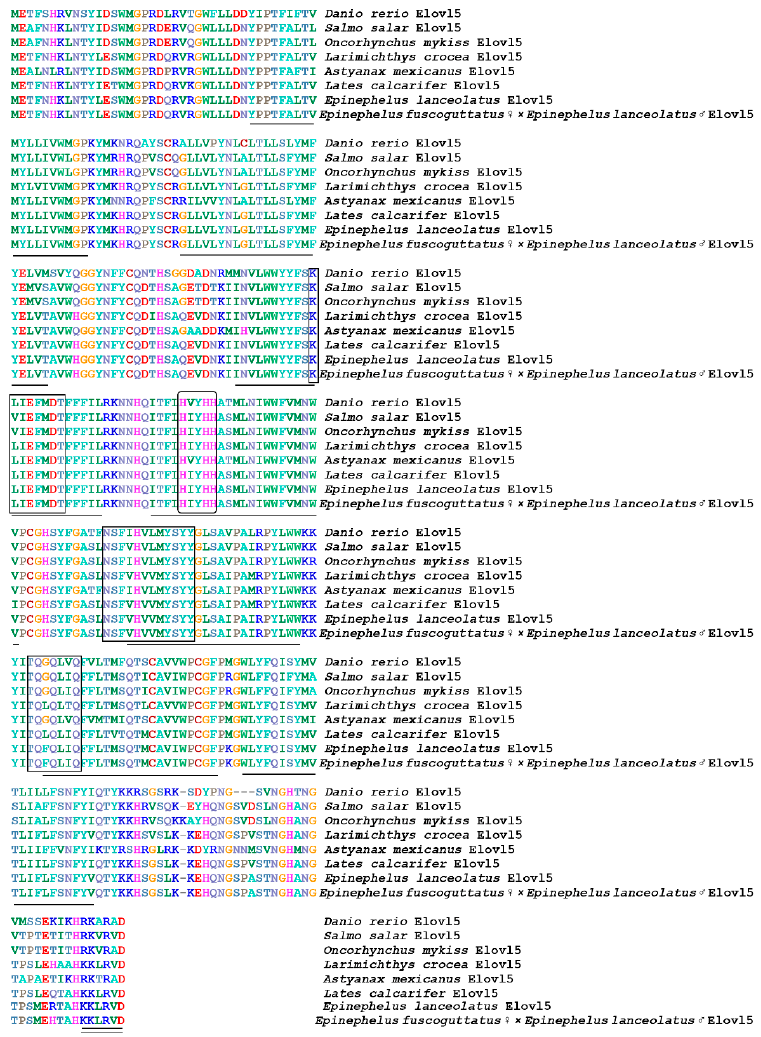
Figure 1. Multiple amino acids sequence alignment of Elovl5 from different fish species. The transmembrane region of amino acids is represented by a straight line; the conserved motif is marked with a square; the histidine box is marked with an ellipse, and endoplasmic reticulum signal is marked with a double line.